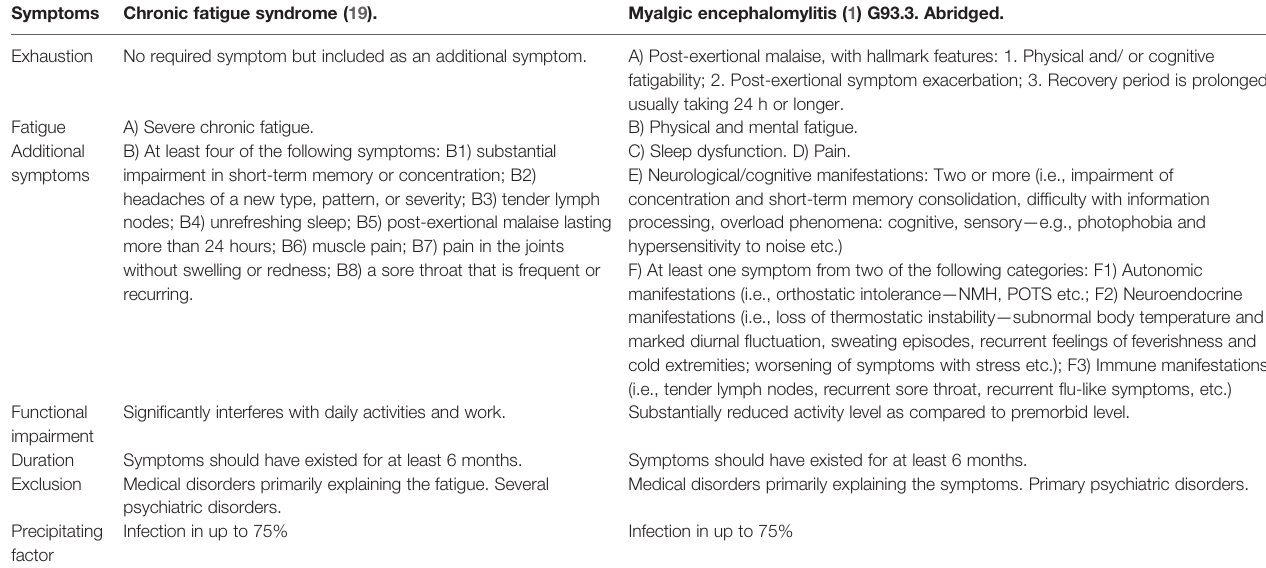
TABLE 1 | Comparison of set of criteria for ME/CFS according to CDC/Fukuda (19) and Canada (1), both coded as G93.3 in ICD-10. Symptoms Chronic fatigue syndrome (19). Myalgic encephalomylitis (1) G93.3.